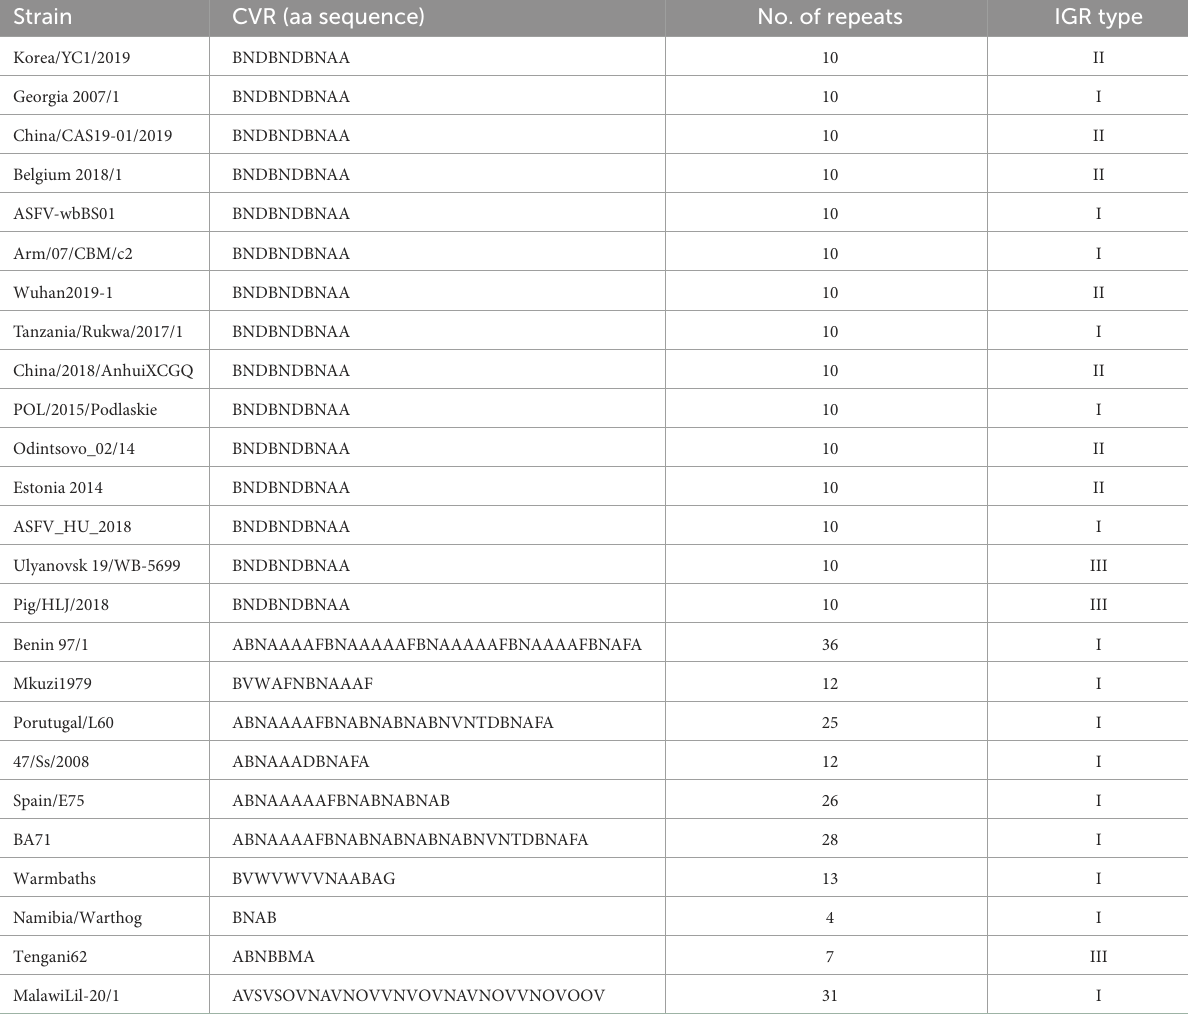
TABLE 3 Tetrameric amino acid sequence in the central variable region (CVR) of B602L in ASFV strains. Strain CVR (aa sequence) No. of